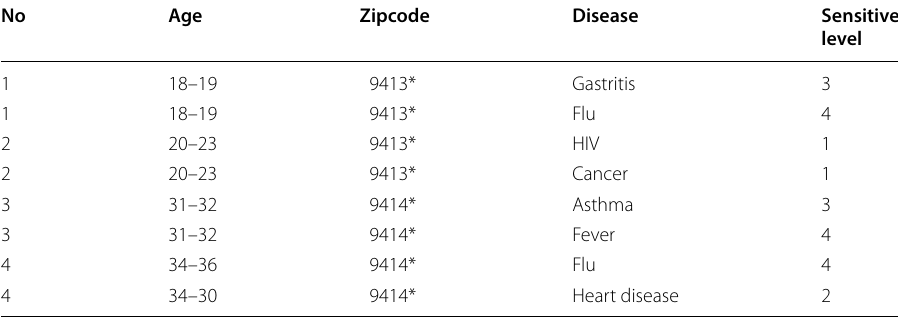
Table 6 after 1st level of